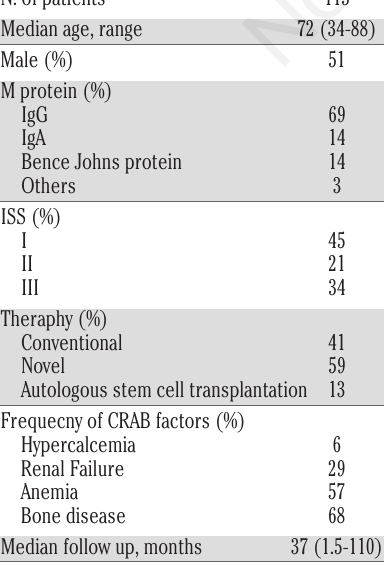
Table 1. Patients’ characteristics.